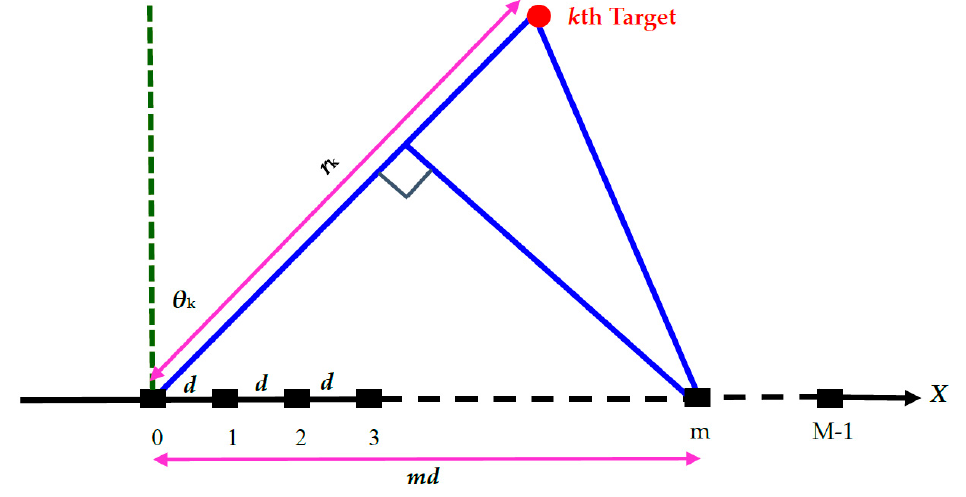
Figure 1. The k th near-field target observed by a M -element uniform linear array.